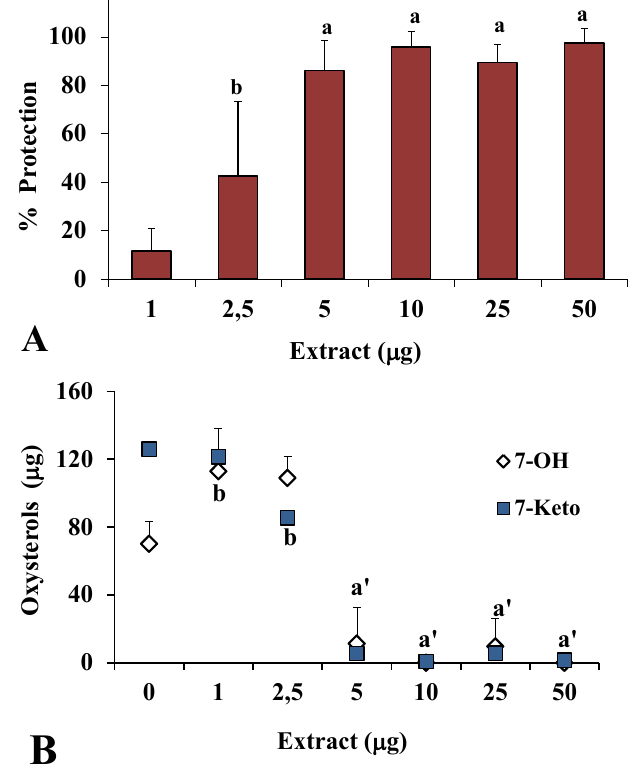
Figure 2. Antioxidant activity (% protection) of different amounts (1–50 μg) of methanolic extract of C. coccineum measured during cholesterol degradation at 140 °C for 1 h ( A ) and values (μg) of the oxysterols 7-keto and 7β-OH formed in the absence (0, oxidized control) and in the presence of extract ( B ); a = P < 0.001, b = P < 0.01 versus oxidized control (0), a’ = P < 0.001 for both oxysterols versus 0 ( n =